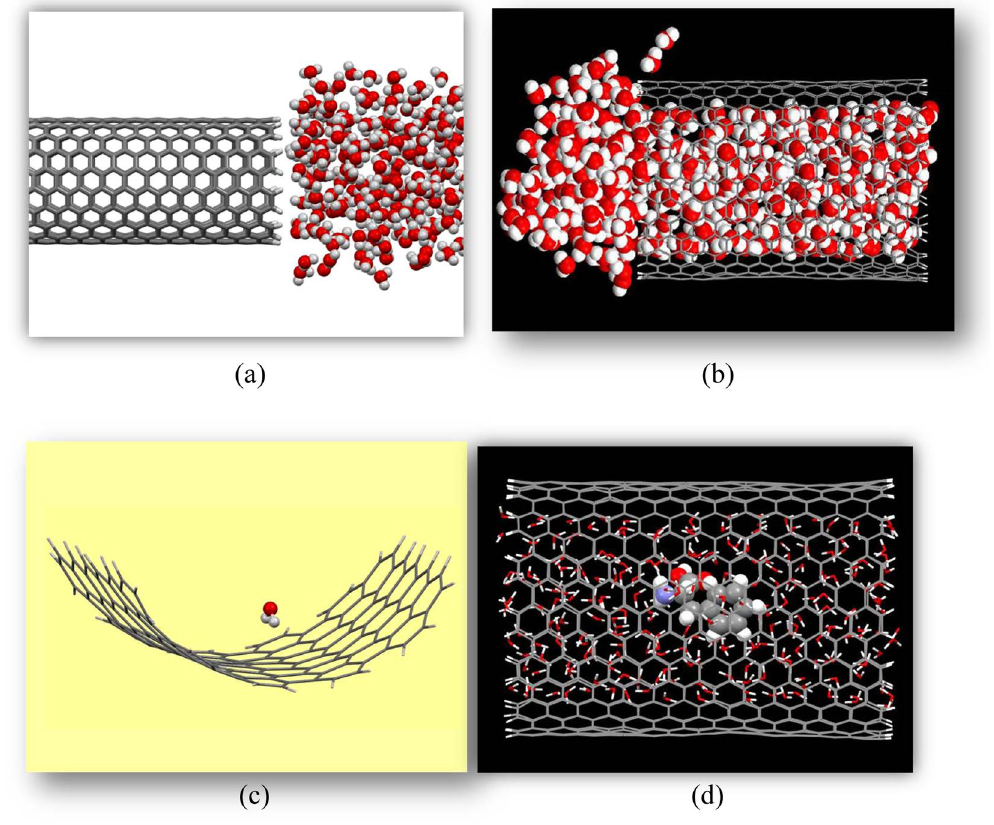
Figure 1. Schematic representation of water/CNT system ( a ) before and ( b ) after optimization within MD simulation, ( c ) schematic representation of a single water molecule attached to the interior sidewall of a (15, 15) CNT, ( d ) water molecules and phenylalanine as a drug molecule confined in a (26, 0) CNT.